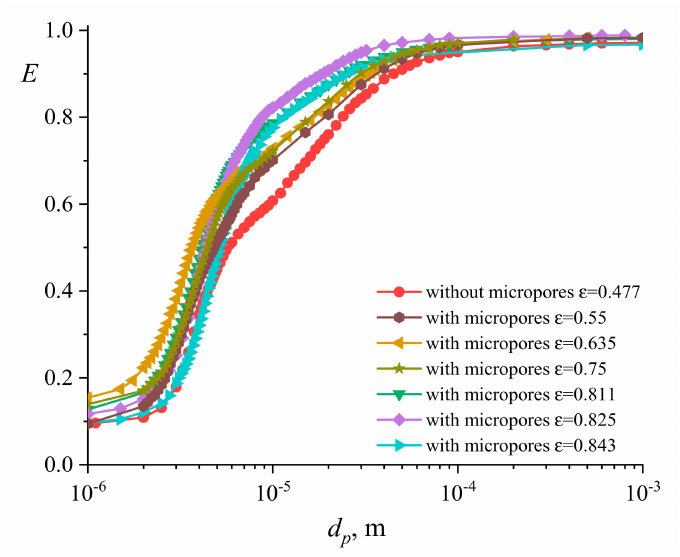
Figure 8. Dependence of the particle deposition efficiency on the particle diameter for models with and without micropores.